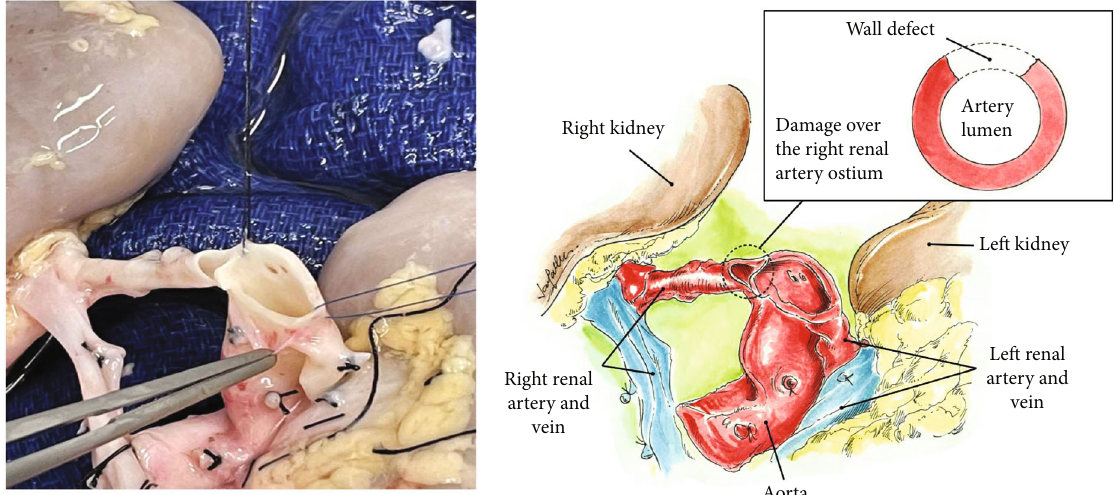
Figure 1: Aorta and damaged renal artery at the level of its takeo ff